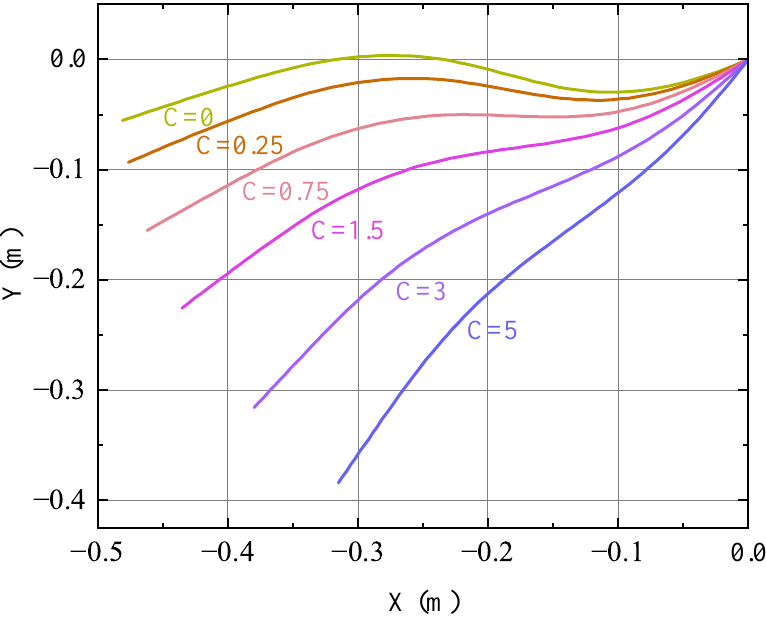
Figure 8. The simulation under different air resistances at t = 0.68